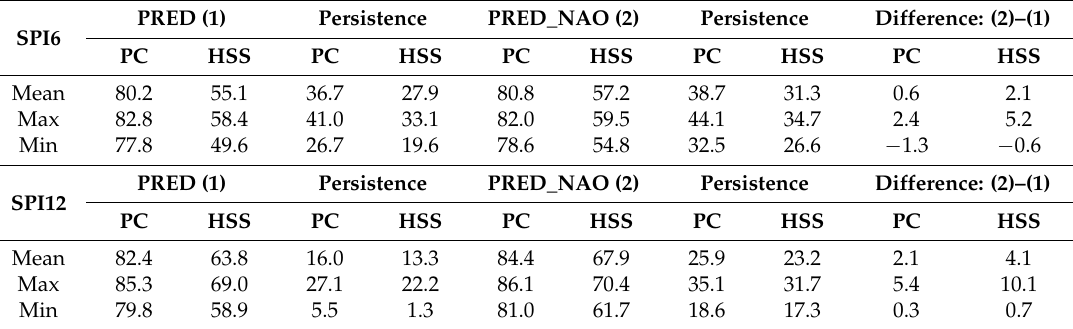
Table 9. Mean, maximum and minimum of the PC and HSS skill scores (%) for the SPI6 (above) and SPI12 (below) for the extended winter